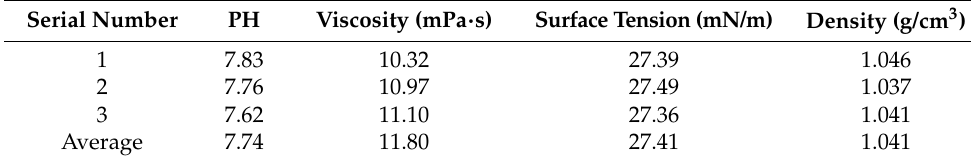
Table 10. Physical and chemical properties of dust